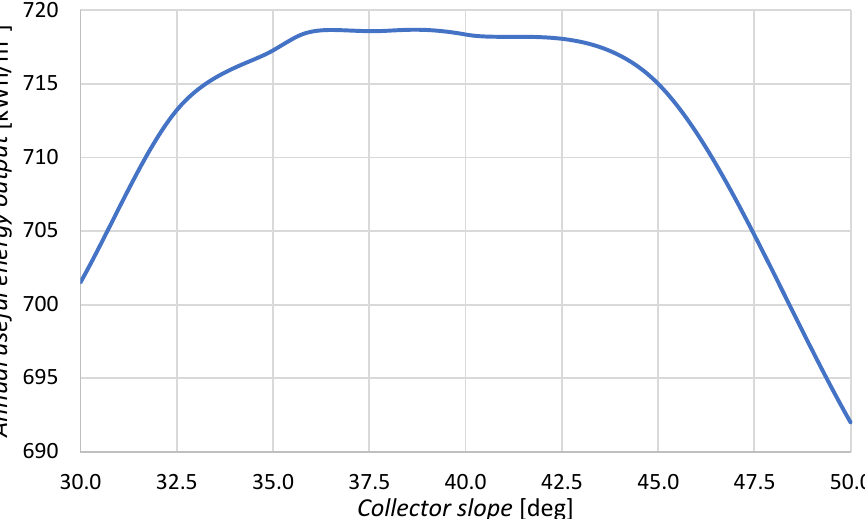
Figure 7. Dependence of the inclination angle of the solar collector on annual useful energy output for Madrid.